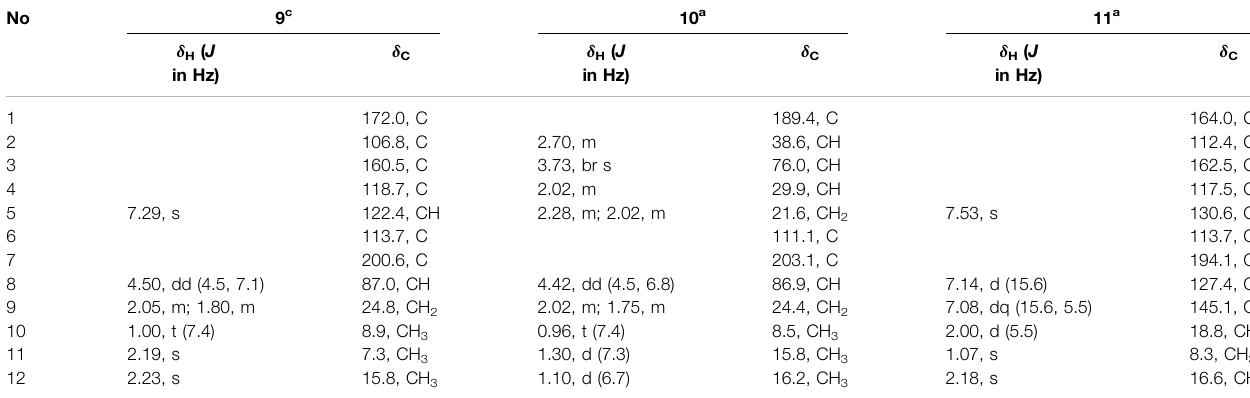
TABLE 5 | 1 H (500 MHz) and 13 C (125 MHz) NMR data ( δ in ppm, J in Hz) of 9 – 11.